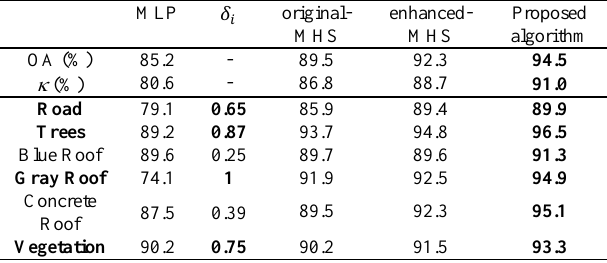
Table 1.The classification accuracies obtained on the Quebec City dataset.